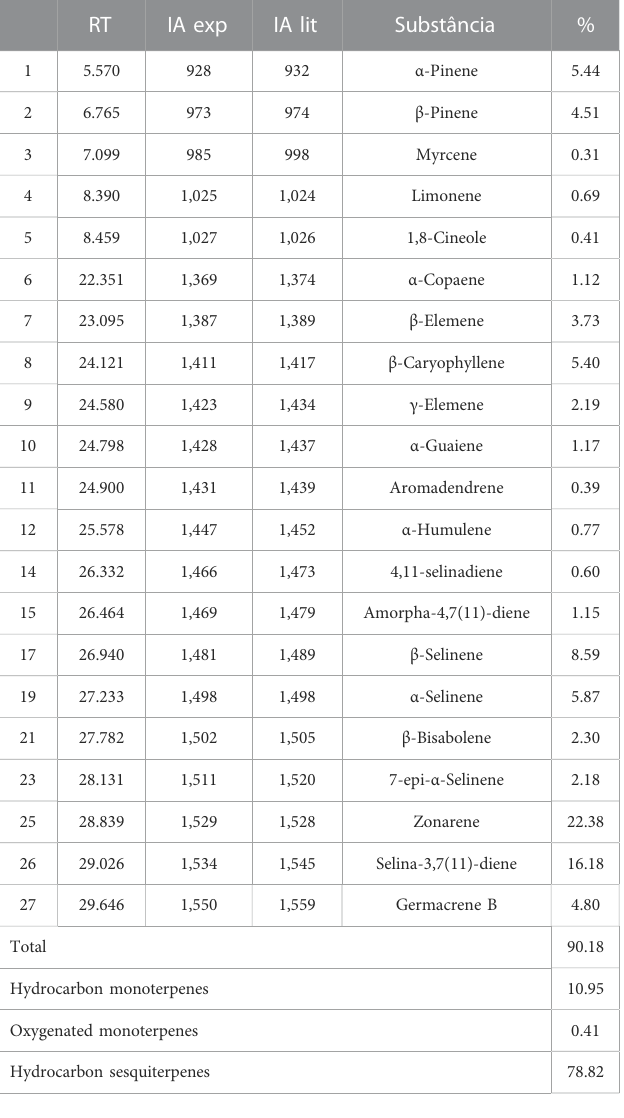
TABLE 1 Chemical characterization of Neomitranthes obscura essential oil from leaves obtained from GC-MS chromatogram. RT IA exp IA